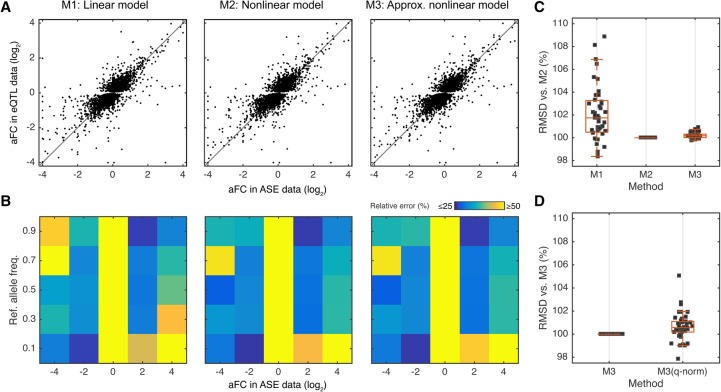
Comparison of the methods for estimating aFC using GTEx data. (A) aFC as estimated from ASE data versus estimates from eQTL data using linear model (M1), nonlinear model (M2), and the nonlinear model (M3) approximation for all top eQTLs in adipose subcutaneous. All three estimates are ∼75% correlated with estimates from ASE data. (B) Quality of the eQTL estimates as a function of allele frequency and the aFC estimate from allelic expression data, evaluated by average relative error between aFC from ASE data and from eQTL estimates. (C) Concordance between the estimates from allelic expression and eQTL data as evaluated by RMSD between the most accurate method, M2, and the other two methods. Each dot represents one tissue in GTEx. (D) Concordance between the estimates from ASE and eQTL data as evaluated by RMSD, comparing M3 to M3 applied after quantile normalization within each genotype group. Each dot represents one tissue in GTEx.